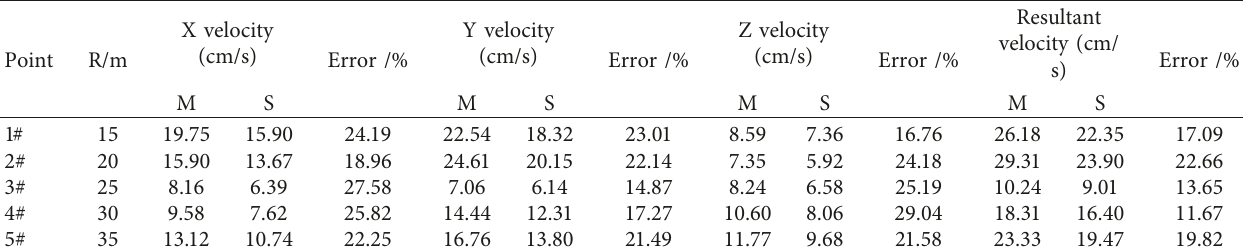
Table 5: Comparison of simulated and measured values of peak particle velocity (without in situ